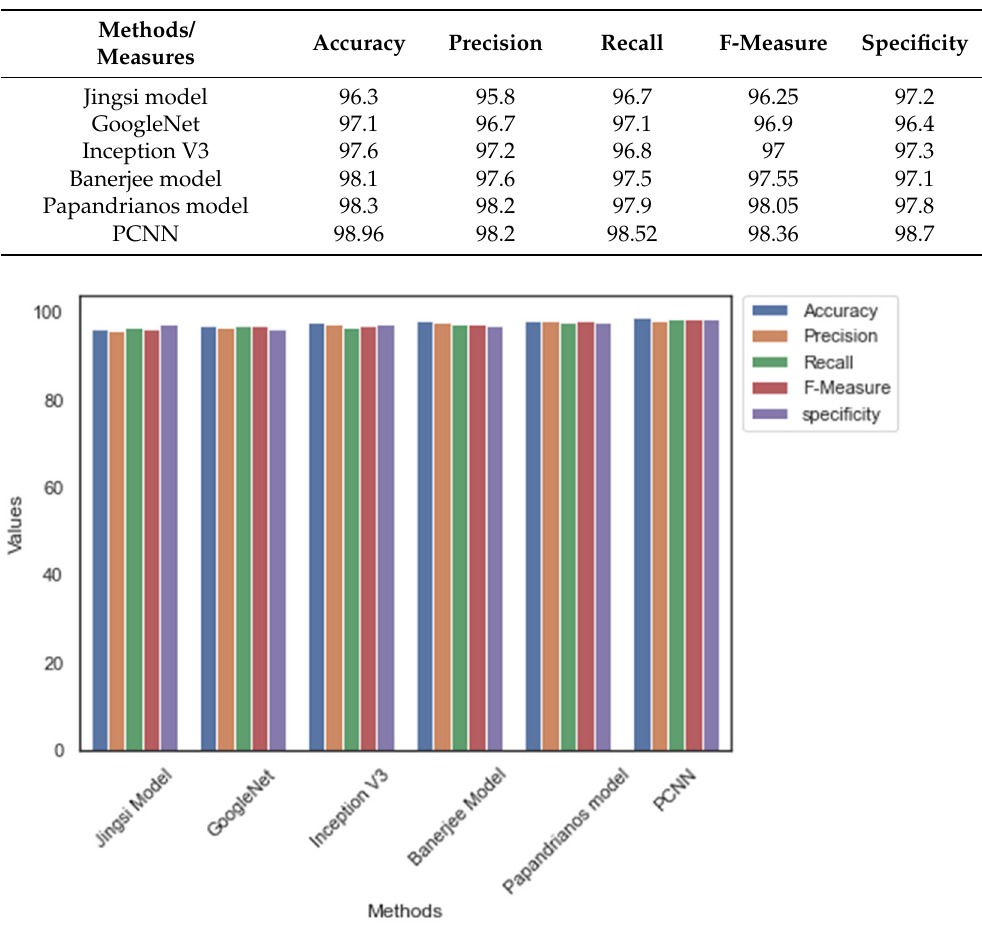
Figure 9. Comparative analysis outcome: Dataset_1.